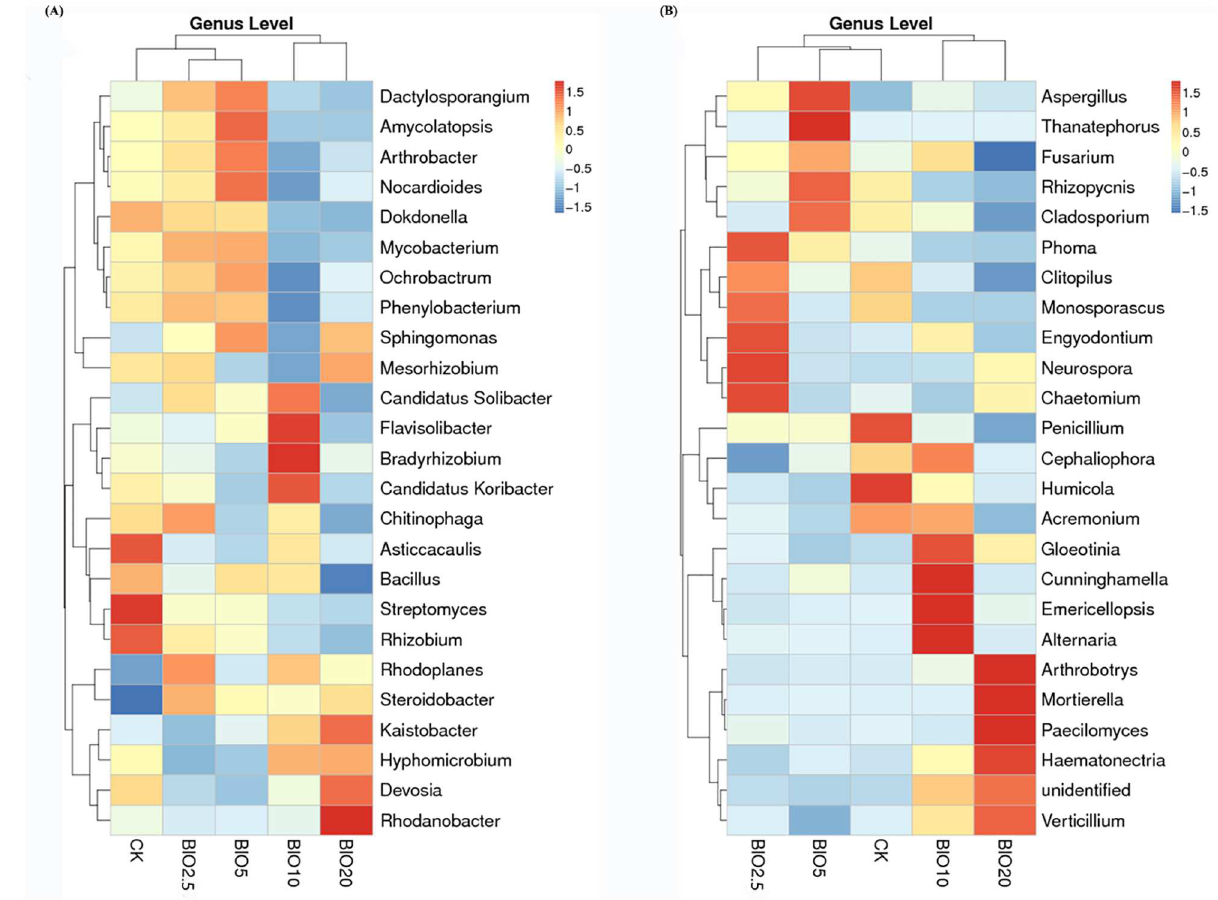
Fig 8. Hierarchical cluster analysis based on the relative abundances of the top OTUs identified in the five samples in the bacterial (A) and fungal (B)